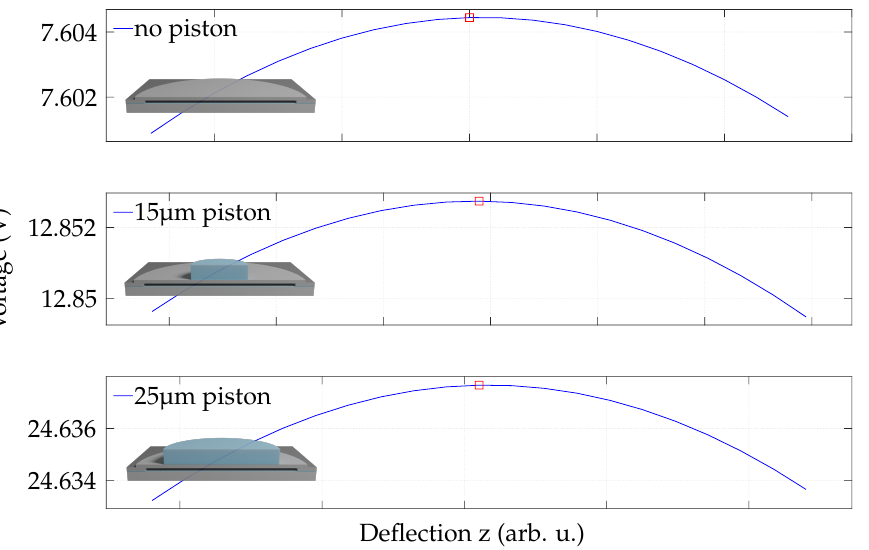
Figure 5. Simulated pull-in voltage of a single cell. The values right to the maximum of each graph are unstable solutions calculated by the quasi-static solver approach. The pull-in voltage is extracted at the maximum of each graph (red markers) for the presented